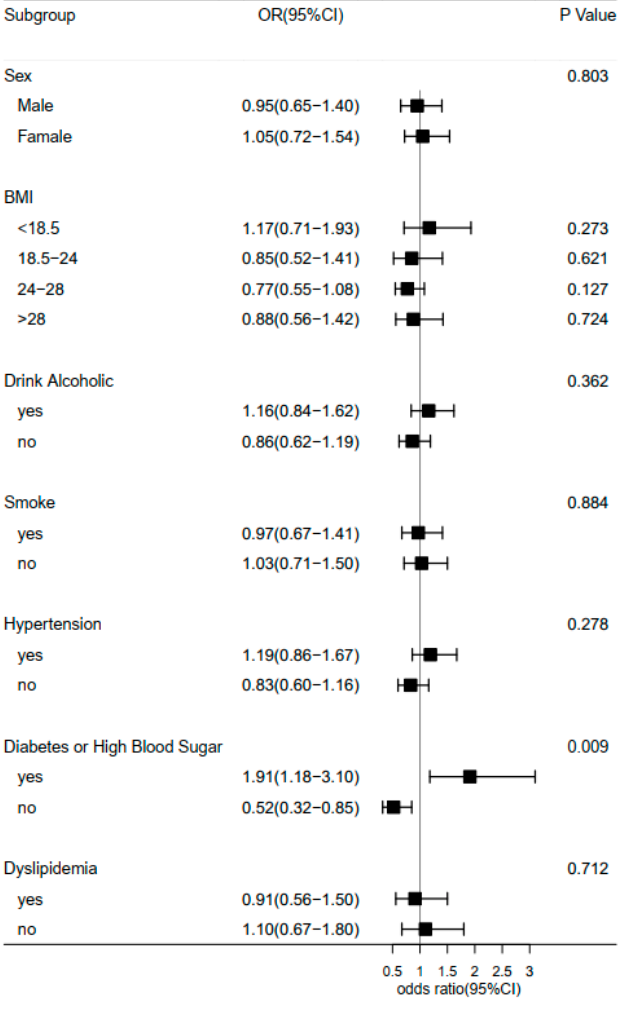
Figure 3. Forest plot of logistic regression analysis of sleep duration and risk of hip fracture, stratified by baseline information.